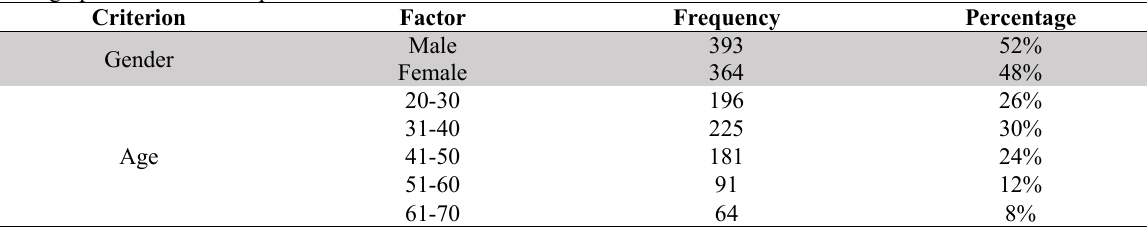
Demographic data of the respondents Criterion